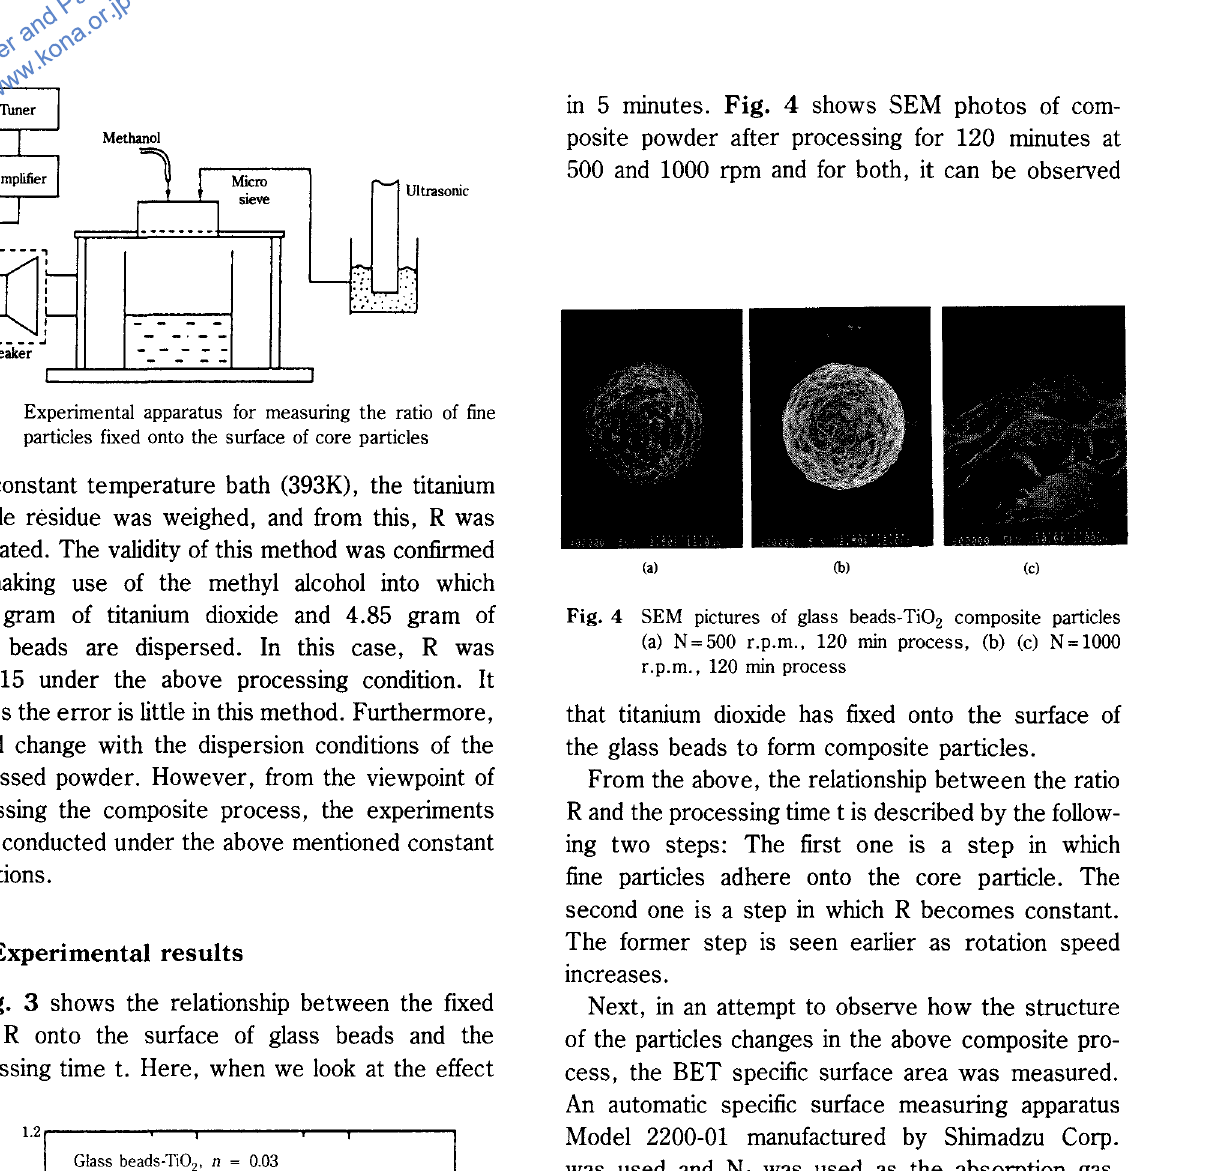
Change of the ratio of fine particles fixed onto the surface of core particles with processing time (glass beads - Ti0 2) of rotation speed, the spread of data is observed at 500 rpm, but R increases with processing time and becomes constant at about 0.9 in 5 minutes or more. With rotation speed exceeding 750, R reaches 1.0